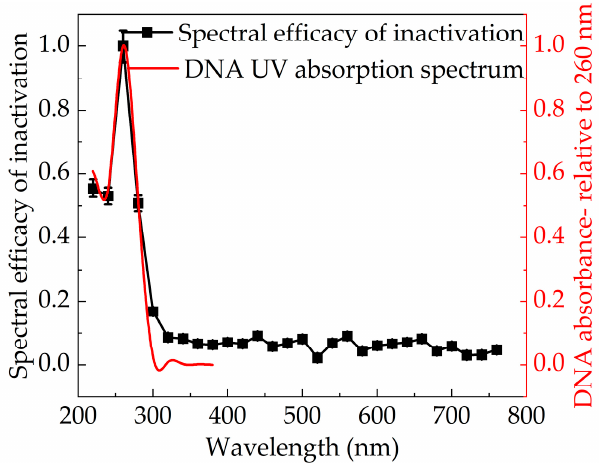
Figure 10. UV–visible spectral efficacy of pulsed xenon lamp inactivation.